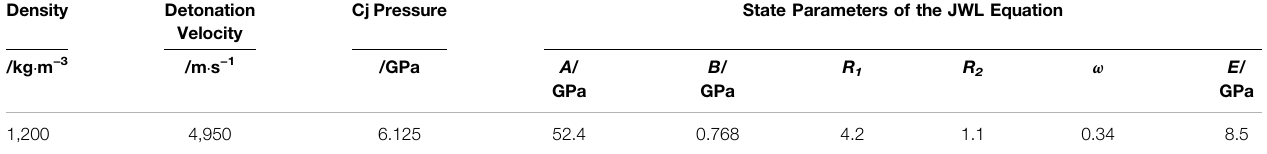
TABLE 3 | Explosive material and its state equation parameters. Density Detonation Cj Pressure State Parameters of the JWL Velocity